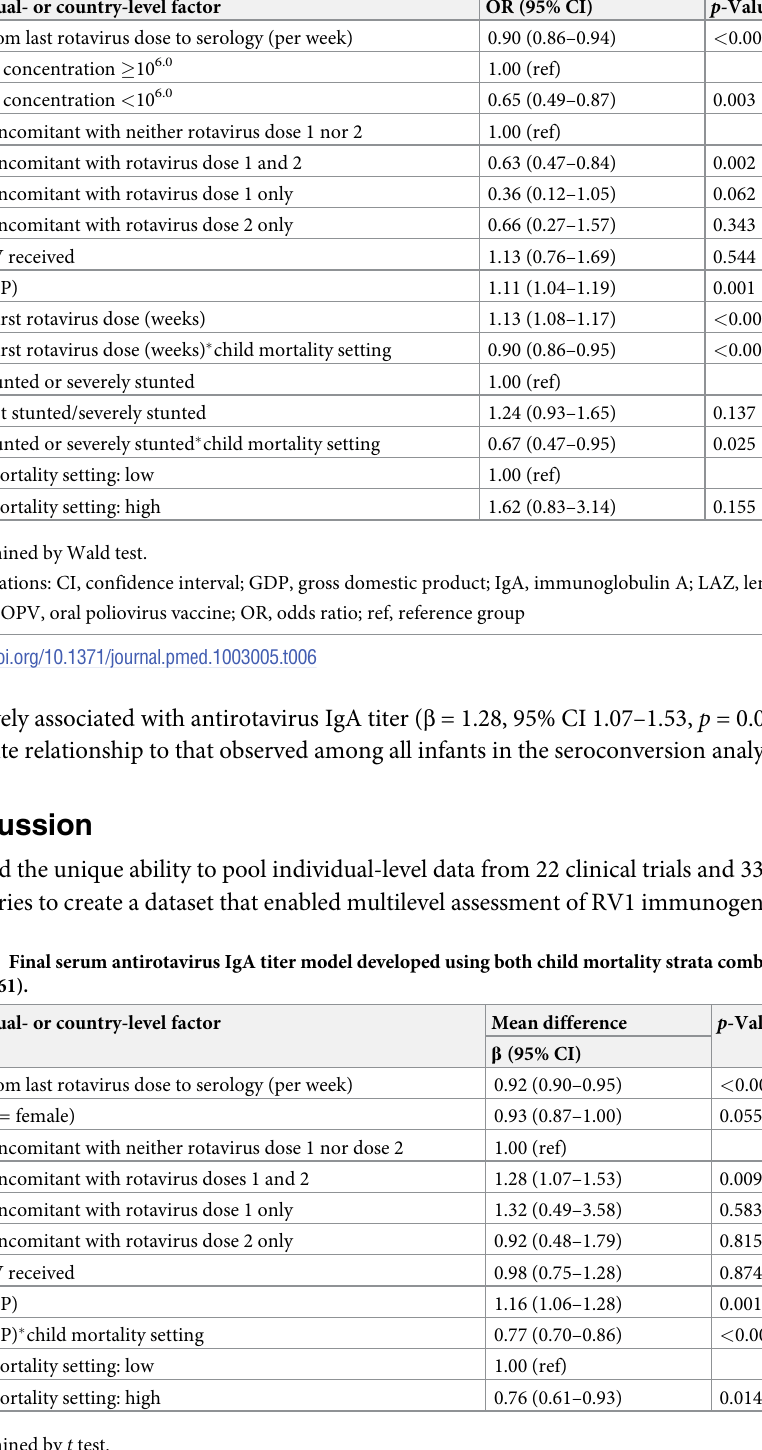
Table 6. Final serum antirotavirus IgA seroconversion model developed using both child mortality strata com- bined ( n = 6,589). Individual- or country-level factor OR (95% CI) Time from last rotavirus dose to serology (per week)